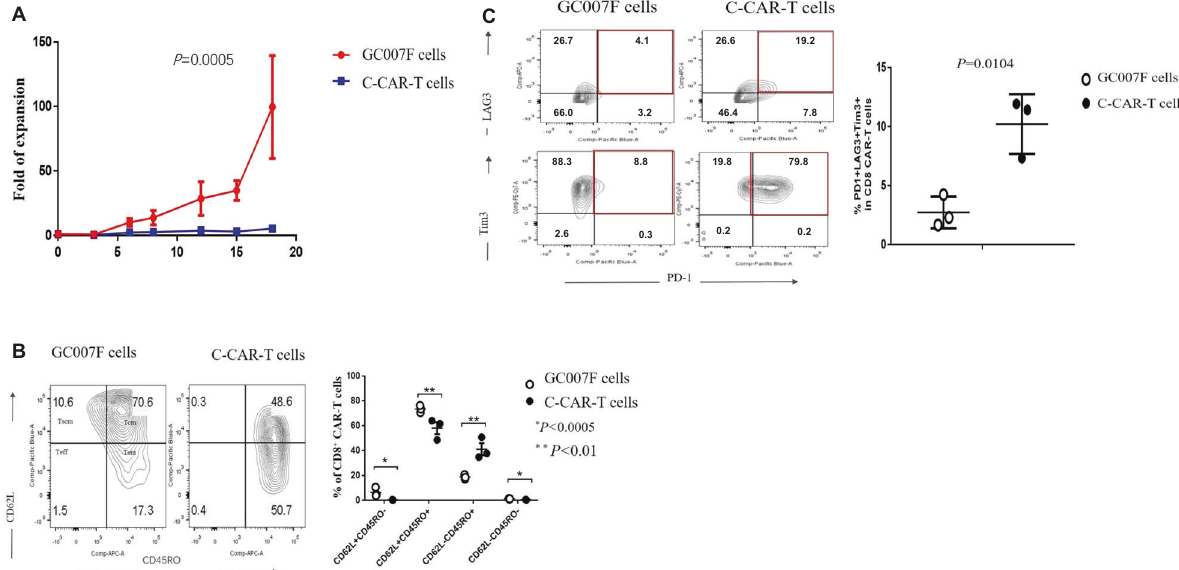
Fig. 2 Characteristics of GC007F cells. Proliferation-, phenotype-, and expression-related cell-surface markers were examined by fl ow cytometry. A Proliferation of GC007F cells. B T cell memory and stemness features were characterized by surface staining of GC007F cells and C-CAR-T cells for CD45RO and CD62L and evaluation using fl ow cytometry (left) and statistical analysis (right). CD62L + CD45RO + central memory T cells (T CM cells) and CD62L - CD45RO + effector memory T cells (T EM cells). C T cell exhaustion was characterized by surface staining for PD-1, LAG3 and Tim3, which was analyzed using fl ow cytometry (left) with statistical analysis of the % of PD1 + LAG3 + Tim3 + cells